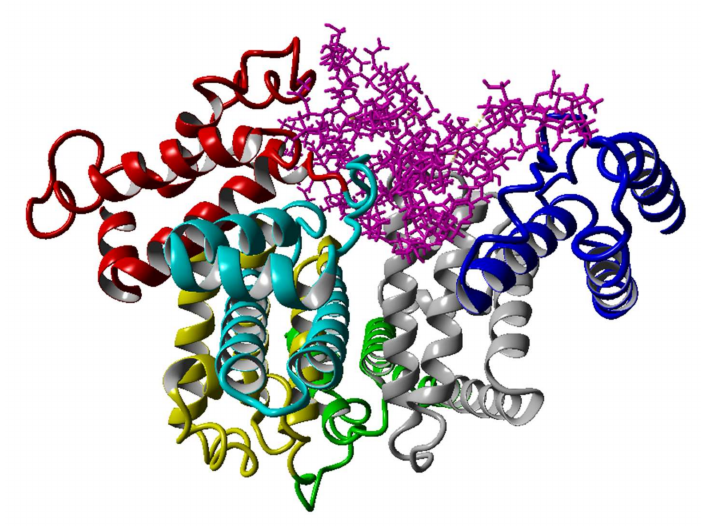
Figure 2. Structure of human serum albumin with different coloring for the different HSA subdo- mains: IA—red; IB—cyan; IIA—yellow; IIB—green; IIIA—grey; IIIB—blue. Hyaluronate is colored pink. The figure represents one of many structures of the HAS–hyaluronate complex. This particular complex is referred to as complex number 1 in Table